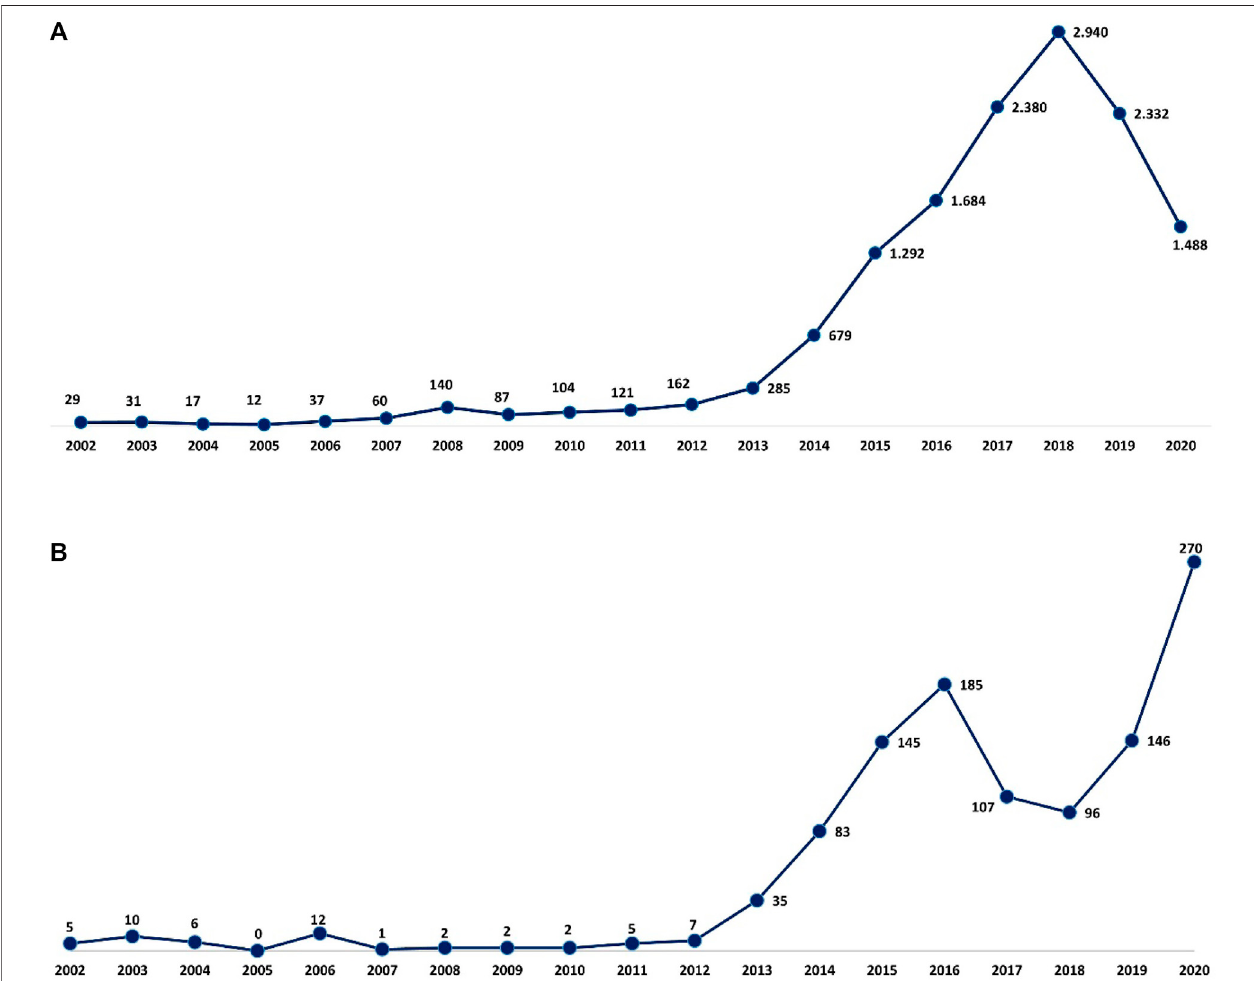
FIGURE 1 | Italian (A) and Sicilian (B) trend of ADR reports related to drugs approved for MS over the years. ADR, adverse drug reaction; MS, multiple sclerosis.